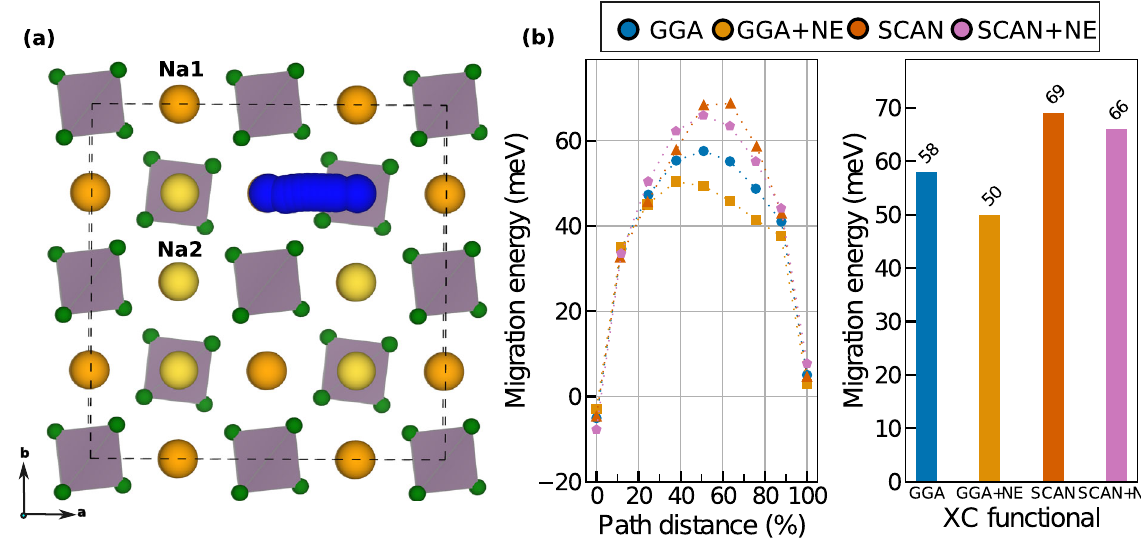
Fig. 4 MEPs and the corresponding barriers for Na 3 PS 4 . a 2 × 2 × 2 supercell of Na 3 PS 4 . Na1 and Na2 sites are represented by orange and yellow spheres, respectively. Blue spheres indicate the Na migration pathway. b MEPs and E m for the Na1 → Na2 hop. GGA + NE and SCAN + NE indicate calculations with NELECT